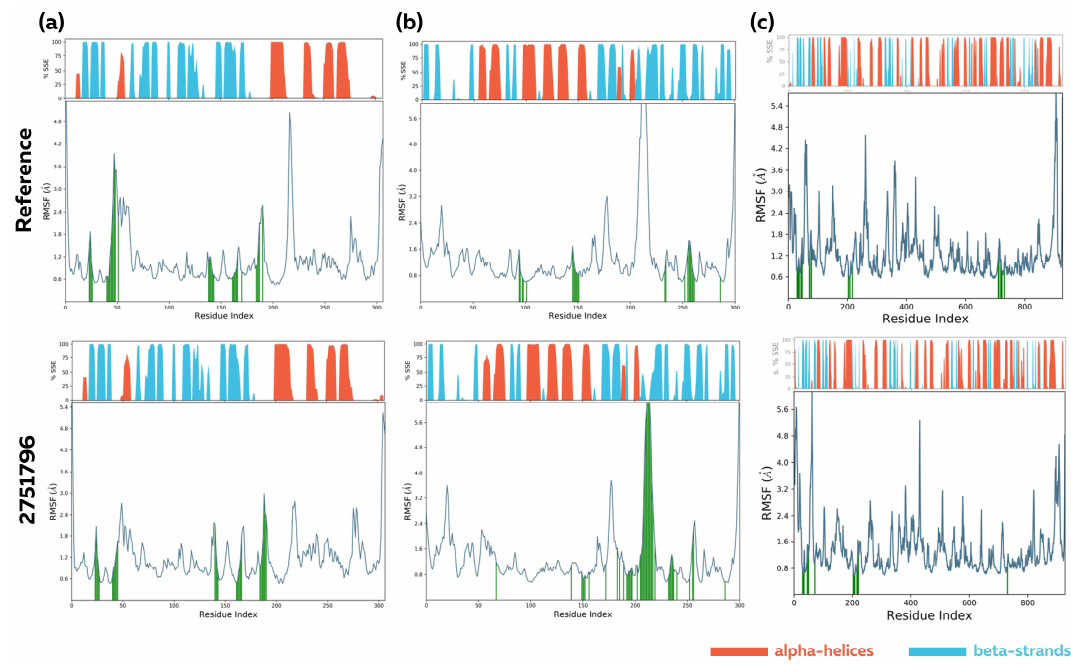
Figure 6. Analysis of RMSF trajectories and secondary structure elements (SSE) distribution over the 100 ns MD simulation for ( a ) Ligand–Mpro, ( b ) Ligand–PLpro, and ( c ) Ligand–RdRp complexes. Protein residues that interact with the ligand are marked with green-colored vertical bars. The al- pha-helices and beta-strands SSEs are shown in red and blue colors, respectively.